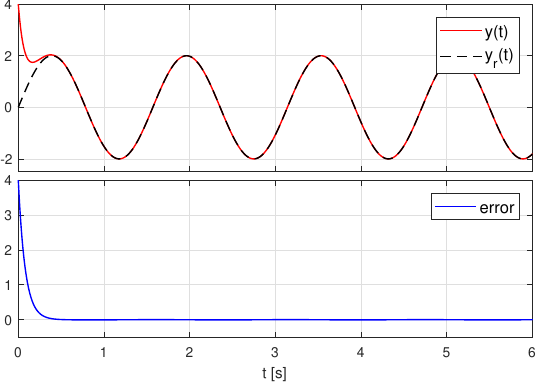
Figure 3. Performance of the regulator for λ = − 2.5, for whose case Γ 1 = 3.0924, Γ 2 = 1, Γ 3 = − 0.5, and Γ 4 =